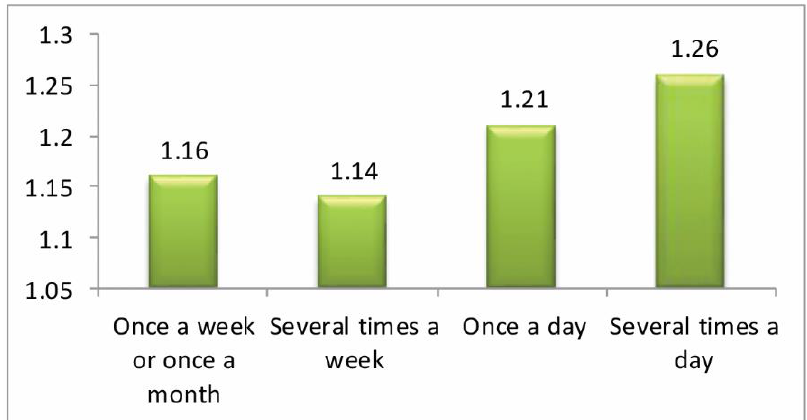
Figure 1. The risk of being a cybervictim (4-point scale), by the frequency of using the internet for the adolescents who used the internet ( n = 1140).